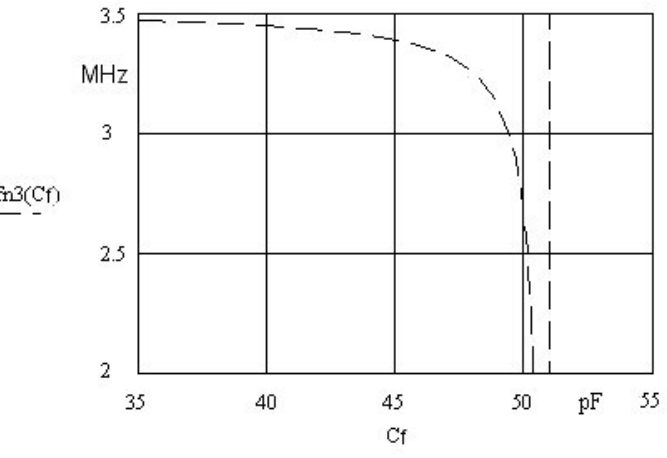
Figure 4. Fine-tuning of the working frequency using C L = 640 m